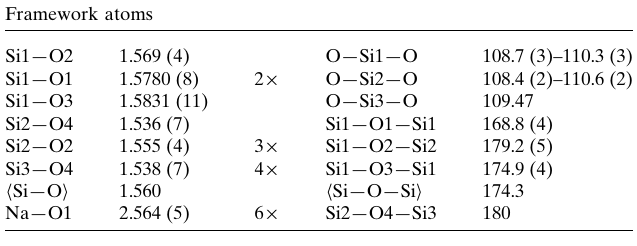
Figure 6 Relationship between the Fd 3 m unit cell ( a ’ 19.4 A˚ , displayed in black) and the monoclinic A 2/ n cell ( a 0 = c 0 ’ 23.7 A˚ and b 0 ’ 13.7 A˚ , in blue; analogous C 2/ c setting in green). The identical lattice points of the cubic F lattice and the monoclinic A lattice are marked by yellow spheres. Gray spheres in the Fd 3 m cell lose translation identity in A 2/ n and C 2/ c .